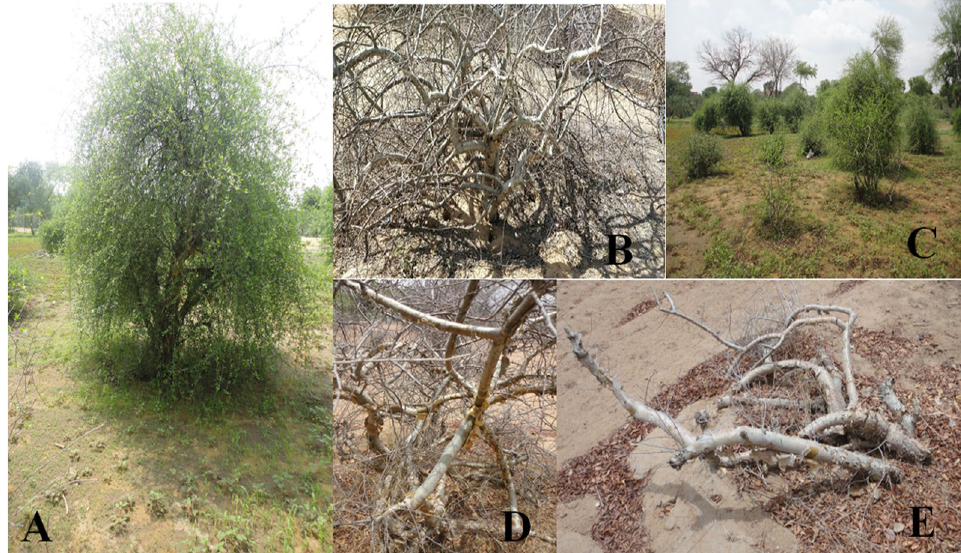
Fig. 1 C. wightii species. Erect habit ( A ); spread/bushy habit deciduous in nature ( B ); plantation for germplasm conservation ( C ); non-woody stem: source of oleo-gum resin ( D ) and non-scientific tapping for gum extraction lead plant death ( E